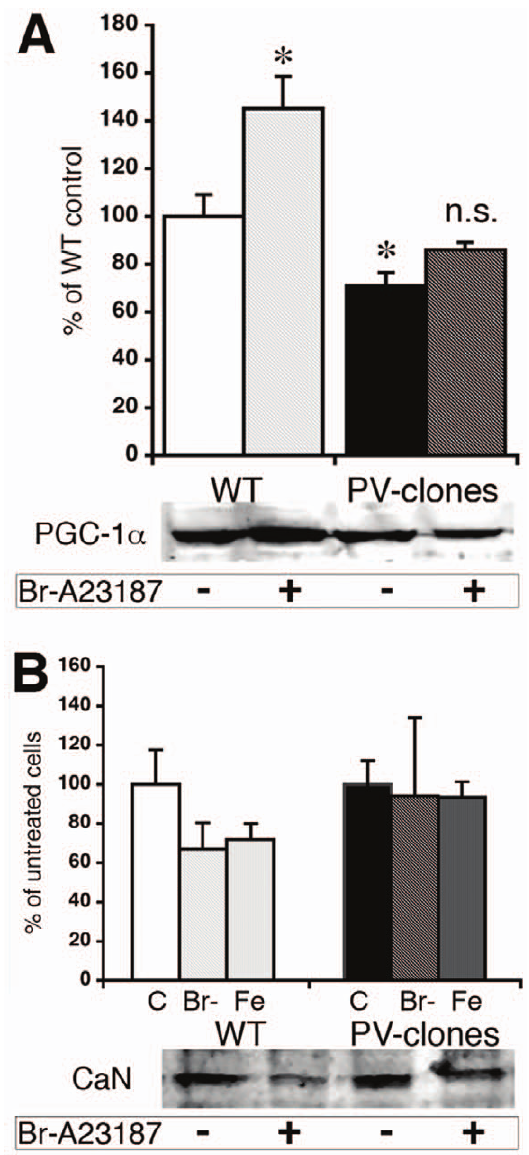
Figure 5. Expression levels of PGC-1 a and CaN in C2C12 cells treated with Ca 2 + ionophores. A) Semi-quantitative analysis for PGC-1 a . The immunoreactive band used for the quantification migrated with an apparent M r of , 90 kDa (calculated M r of PGC-1 a is 90,588 Da), at an identical position as PGC-1 a from TA extracts (Fig. 7C). Mild ionophore treatment (1 m M; 48 h) led to an increase in PGC-1 a in WT C2C12 cells (*; p , 0.05). In untreated PV-clones, PGC-1 a levels were decreased compared to control C2C12 cells (*; p , 0.05); ionophore treatment didn’t additionally affect PGC-1 a levels (n.s.). In the lower part representative Western blot signals used for the calculations are shown. B) Analysis of CaN expression, other details as in A). CaN expression levels were determined in untreated cells (C) or after incubation with the Ca 2 + ionophores Br-A23187 (Br-) or ferutinin (Fe) for 48 h. CaN signals were slightly decreased in WT clones (n.s.) and were unchanged in the PV-clones after ionophore treatment. Lower part: Representative CaN Western blot signals for C2C12 WT and PV-clones 6 Br-A23187. doi:10.1371/journal.pone.0044837.g005 conditions and more emphatically, after ionophore treatment. For CaN the situation was different. In control clones acutely treated with ionophores (Br-A23187 or ferutinin), CaN levels were